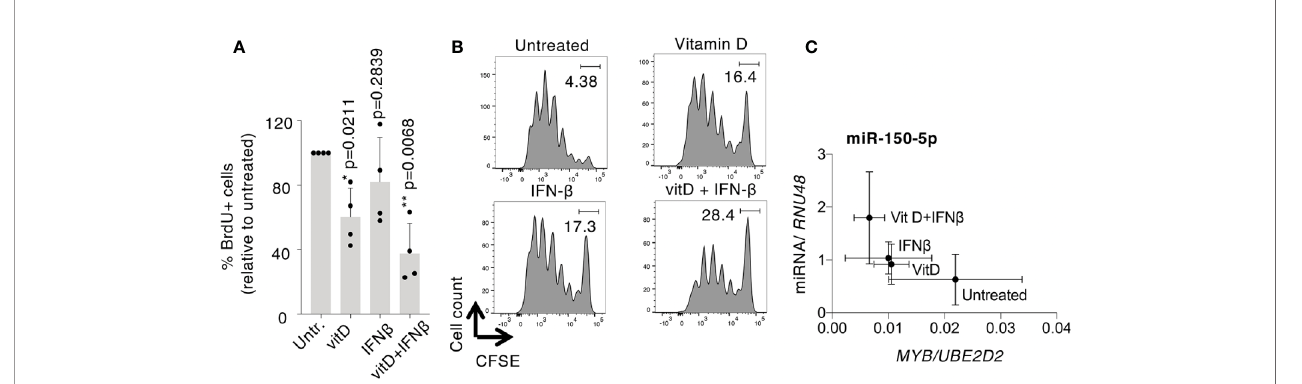
FIGURE 7 | Vitamin D and IFN- b affect human T cell proliferation. T CM cells were treated with vitamin D and/or IFN- b , followed by measurement of cell proliferation by (A) BrdU incorporation [each dot represents one donor (n=4), mean ± SD; paired t-test], or (B) CFSE dilution (representative of n=3 independent experiments). (C) Correlation of mean miR-150 and MYB expression (relative to endogenous controls) across the different treatments. Mean ± SD, n=5